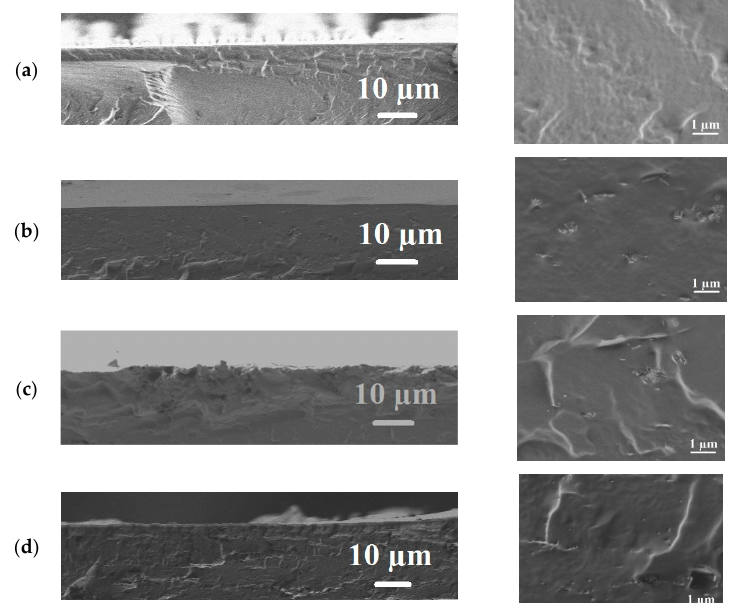
Figure 6. The cross-sectional SEM micrographs at different magnification for the cross-linked PVA and PVA/Zr-MOFs(10%) membranes: ( a ) PVA/GA; ( b ) PVA+MIL-140A(10%)/GA; ( c ) PVA+MIL- 140A-AcOH(10%)/GA; and ( d ) PVA+MIL-140A-AcOH-EDTA(10%)/GA.